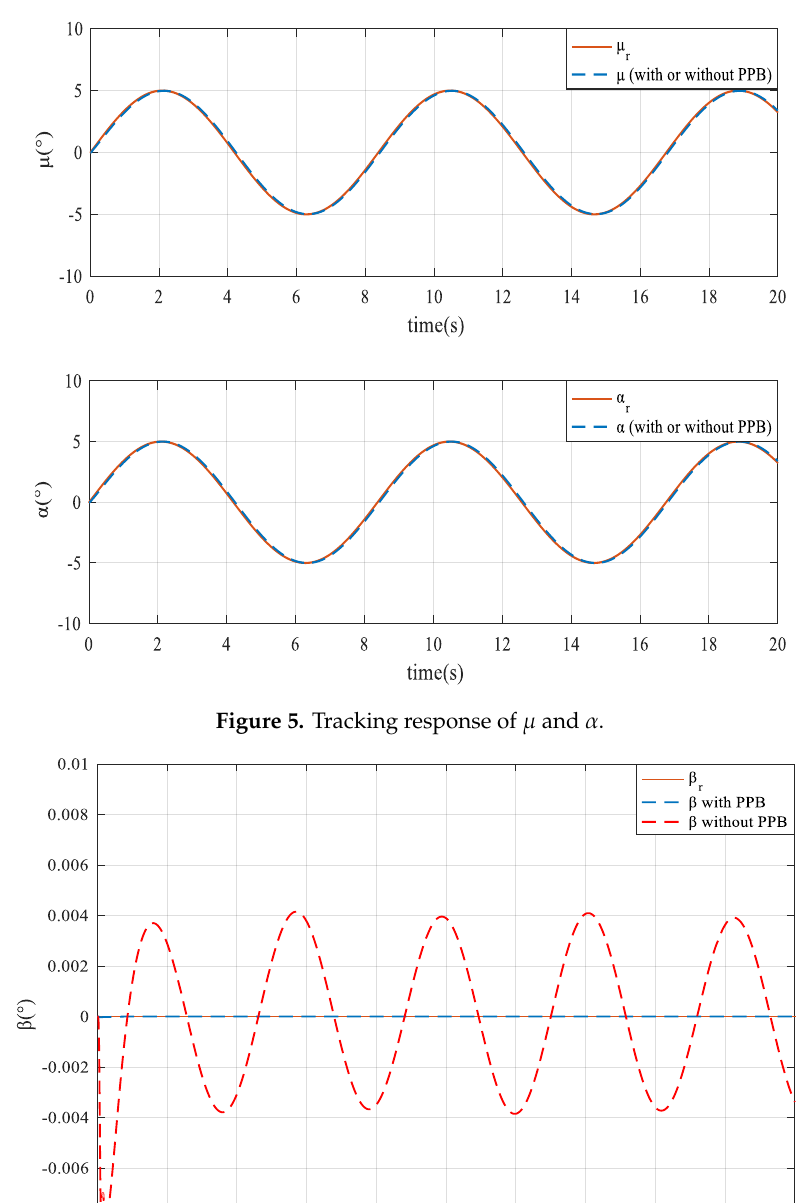
Figure 6. Tracking response of β